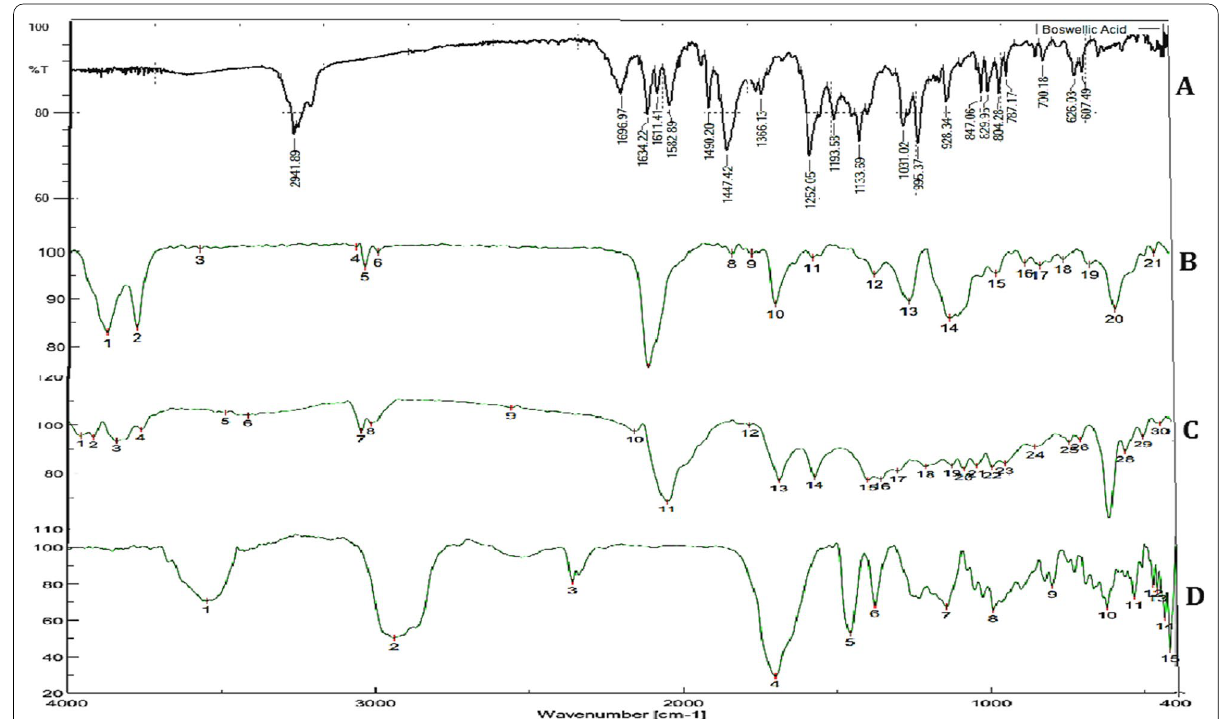
Fig. 3 FTIR spectrum A boswellic acid B BA